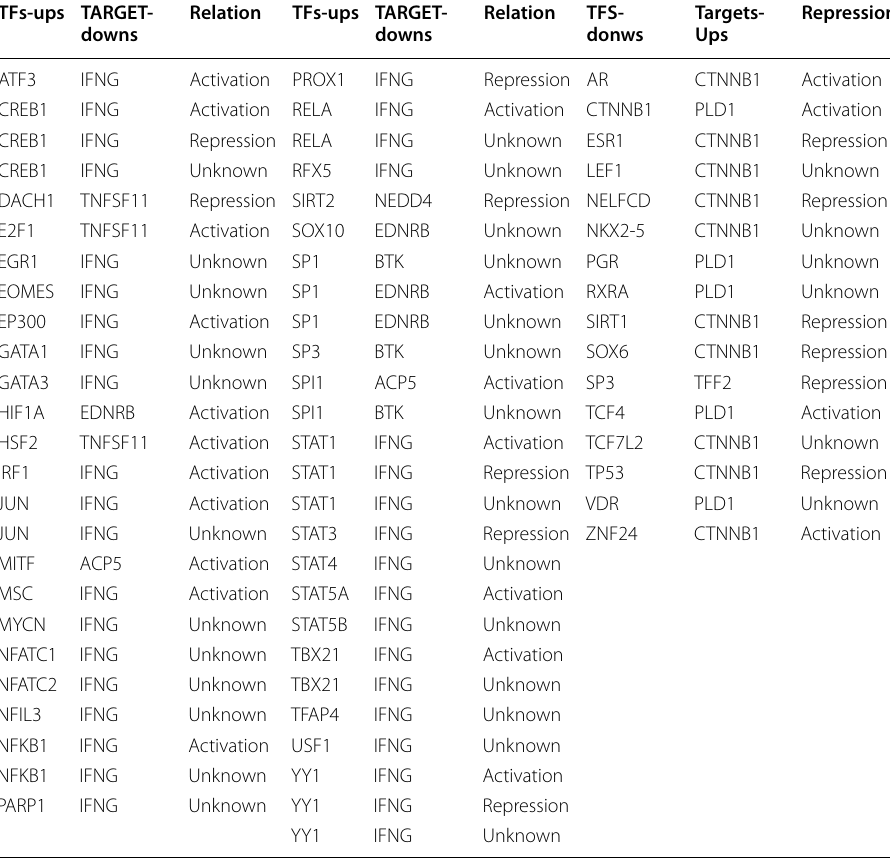
Table 6 The TFs related to both upregulated and down regulated genes. In the upregulated genes the TFs are down and in the down regulated genes the TFs are